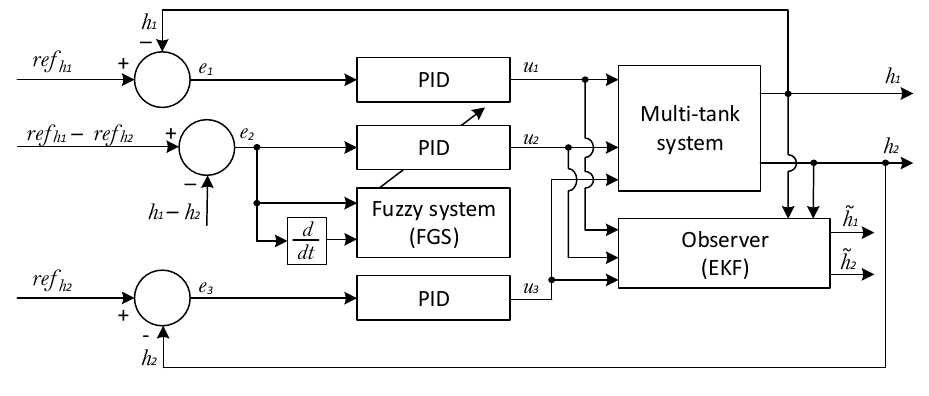
Figure 3. Proposed control